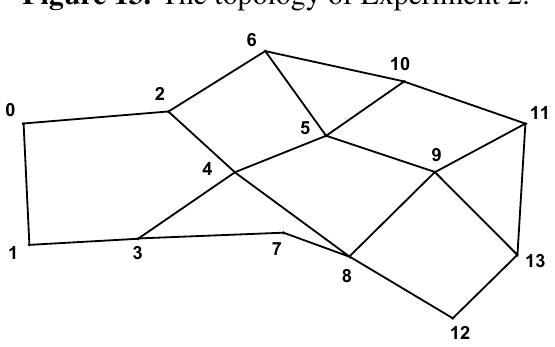
Figure 13. The topology of Experiment